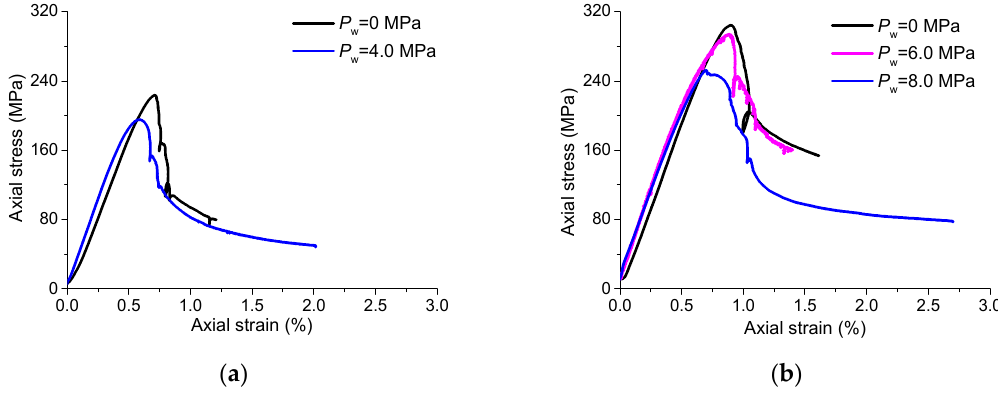
Figure 4. Axial stress–strain curves of the hydro-mechanical experiments affected by different water pressures. ( a ) σ 3 = 5.0 MPa; ( b ) σ 3 = 10.0 MPa.